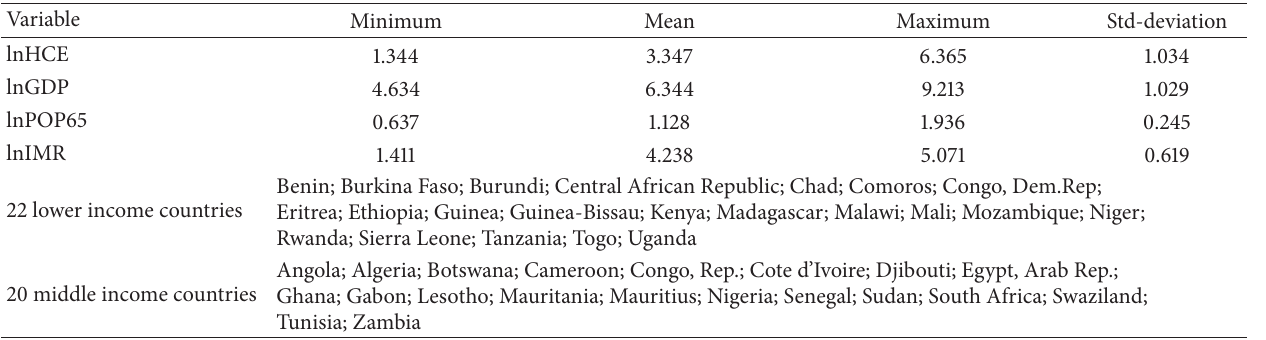
Table 1: Descriptive statistics (1995–2009, observations =